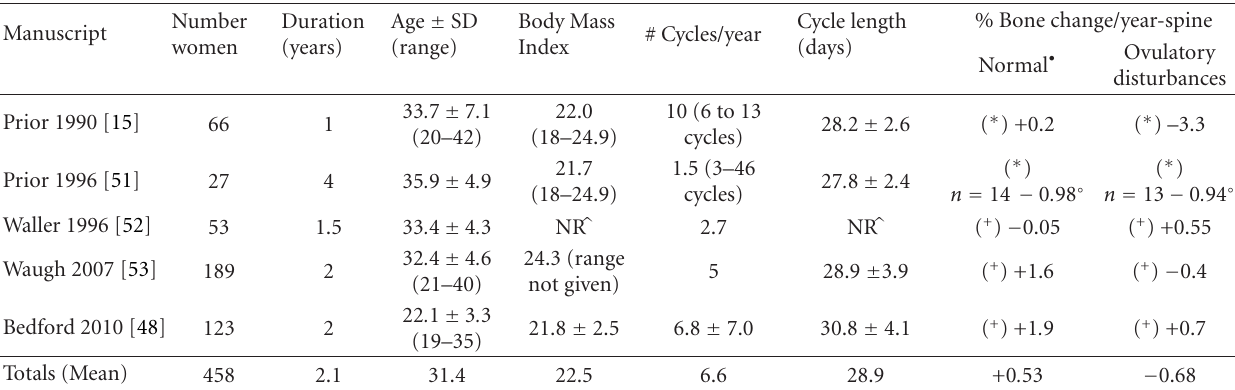
Table 1: Prospective studies of spinal Bone Mineral Density (BMD) change by ovulatory menstrual cycles compared with ovulatory disturbances (anovulation and short luteal phases within normal length cycles). BMD is by Quantitative Computed Tomography ( ∗ ) or Dual Energy X-ray Absorptiometry ( + ). All data are shown as mean ±